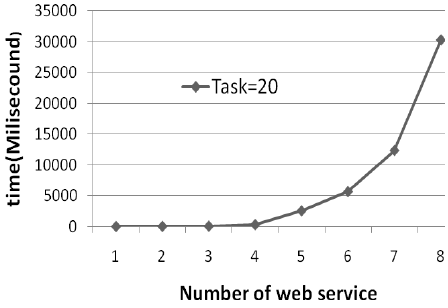
Figureure. 14. Performance of enumeration method